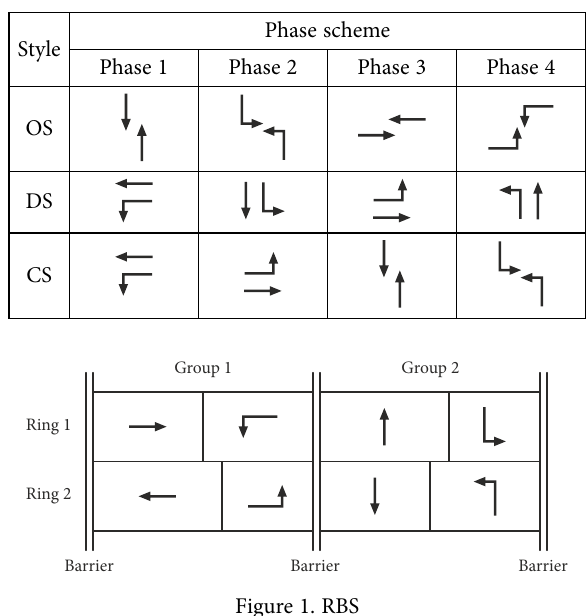
Table 1. Traditional four-PC